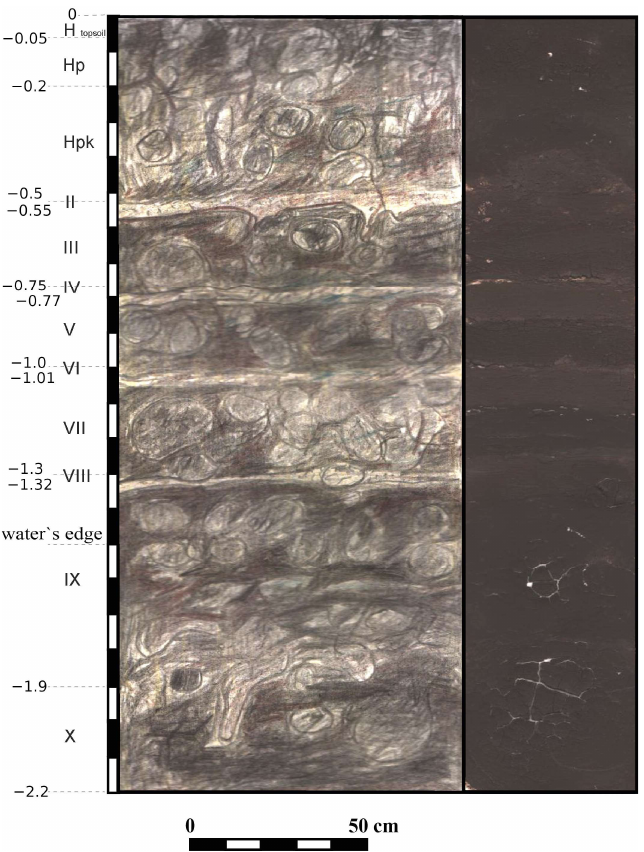
Figure 14. Mykolyna Broiaka. Soil-section 1. Captions: see Supplementary Table S5. Left column: soil horizons’ indices, dotted lines indicate changes of horizons; central column: schematic drawing; right column: photos of actual soil textures from respective horizons of the section, taken afield by gluing a respective sample to a sheet of paper. Elaboration—ZM.